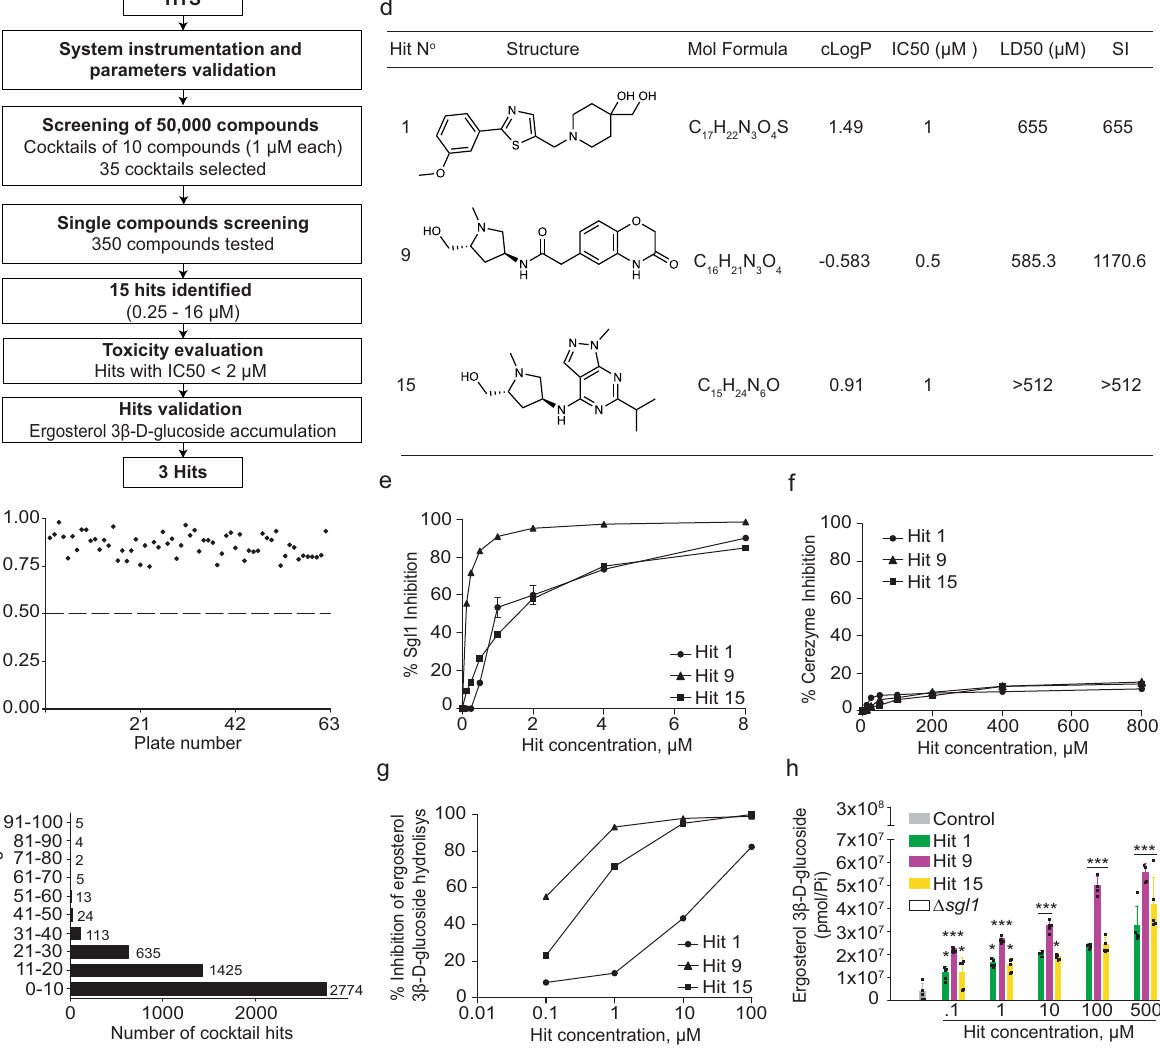
Fig. 4 High-throughput small-molecule drug screening discovers three potent Sgl1 inhibitors with low toxicity. a Flow chart of the HTS campaign. b Z ′ -factor graph of 63 cocktail plates. c Percentage of inhibition of all 5000 cocktail hits. d Top 3 hits selected for validation. Hits 1, 9, and 15 presented good solubility, IC 50 around 1 µ M against Sgl1 and low toxicity to human cell line A549 (LD50>500 µ M) resulting in a selectivity index (SI; SI = LD50/IC50)) higher than 500. e Dose – response curve of hits 1, 9, and 15 using resoru fi n-3 β - D -glucopyranoside as substrate. Data represent the mean±SD for n = 2 independent experiments. f Effect on Cerezyme activity using resoru fi n-3 β - D -glucopyranoside as substrate for hits 1, 9, and 15. All three hits did not potently inhibit Cerezyme showing that these compounds are speci fi c for Sgl1. Data represent the mean±SD for n = 2 independent experiments. g Dose – response curves against Sgl1 for hits 1, 9, and 15 using the native substrate erg-glc. Data represent the mean±SD for n = 2 independent experiments. h Erg-glc accumulation in C. neoformans ( Cn ) wild-type H99 after treatment with Hits 1 (green), 9 (magenta), and 15 (yellow) after 24h of incubation. Erg-glc levels were quanti fi ed by LC-MS. All three hits signi fi cantly increased erg-glc levels compared to the control (untreated Cn H99 cells). Statistical analysis by one-way ANOVA, Dunnett ’ s multiple comparison test; * p <0.05, *** p <0.001. Data represent the mean±SD for n = 5 independent experiments. Control represents untreated wild-type Cn cells. At 500 µ M the accumulation of erg-glc for Hits 1, 9, and 15 was about 10-fold less that the mutant Cn Δ sgl1 . Source data are provided as a Source Data fi